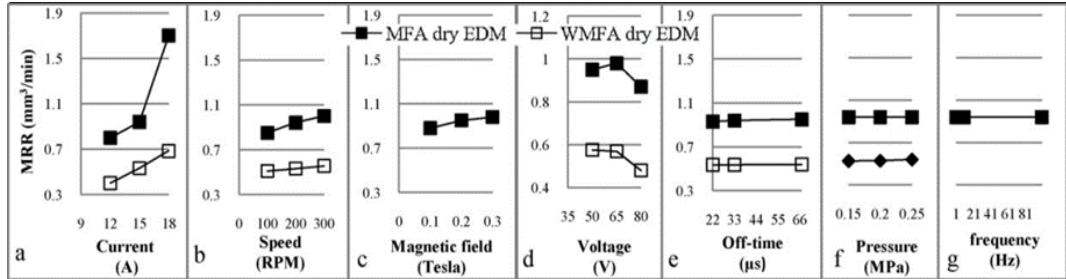
Figure 24. Comparative parametric plots for the MRR in MFA dry EDM and WMFA dry EDM [136].